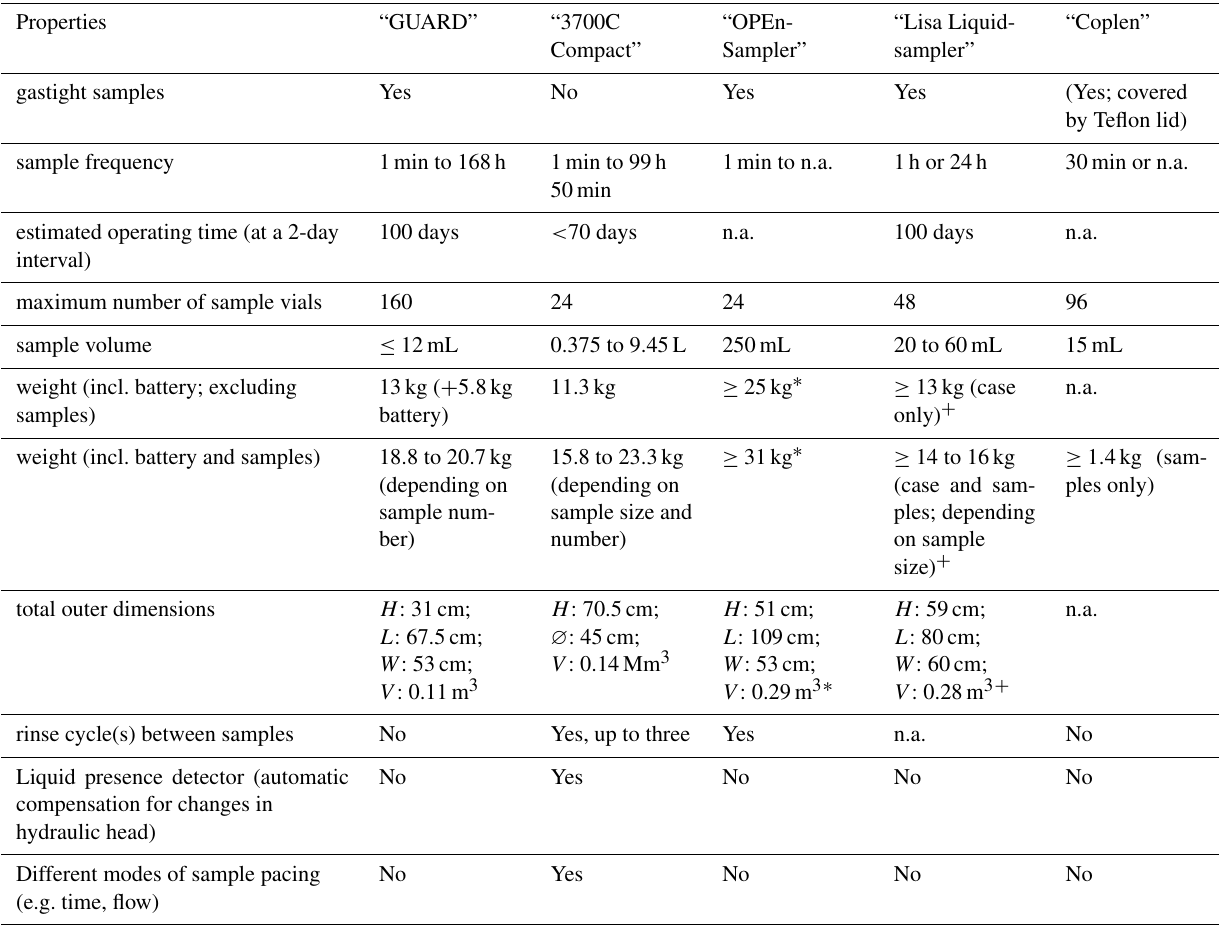
Table 2. Comparison of the GUARD prototype with conventional autosamplers available on the market, represented here by the 3700C Compact from Teledyne ISCO (information retrieved from the manufacturer’s website: http://www.teledyneisco.com/en-uk, last access: 30 June 2018) as well as other non-commercial autosamplers developed by members of the scientific